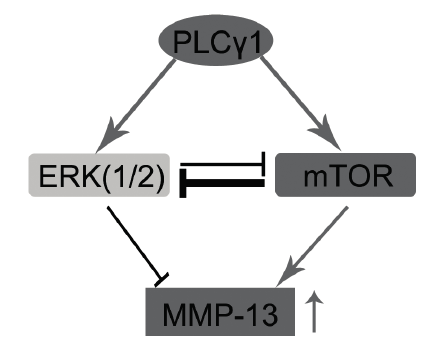
Scheme 1. Schematic representation of mutual inhibition between ERK(1/2) and mTOR in PLC γ 1-mediated up-regulated MMP-13 expression in human OA